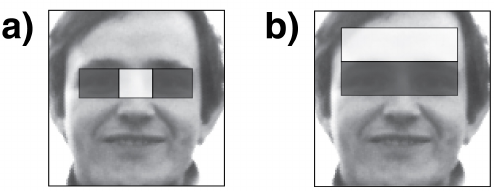
Figure 11. Example of features. ( a ) the nose-bridge tends to be brighter than the eyes; ( b ) the forehead being brighter than the eye region